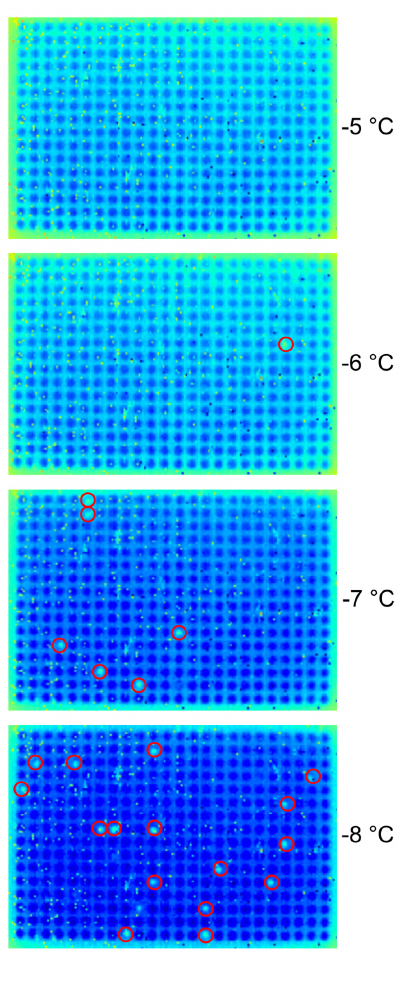
Figure 5. Sequence of infrared camera images showing 384 droplets during cooling. Red circles indicate freezing